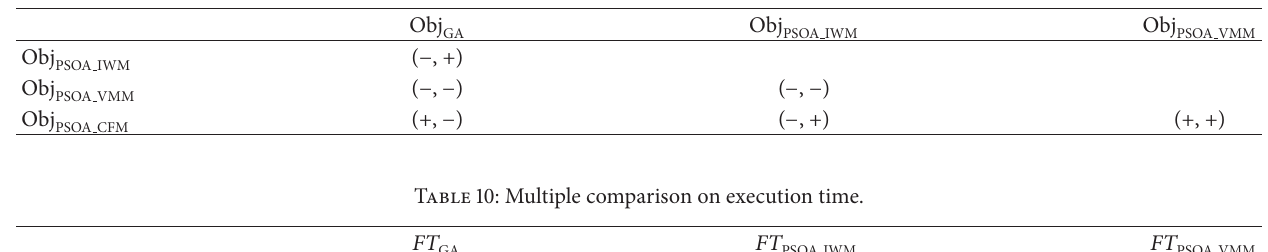
Table 9: Multiple comparison on objective function.